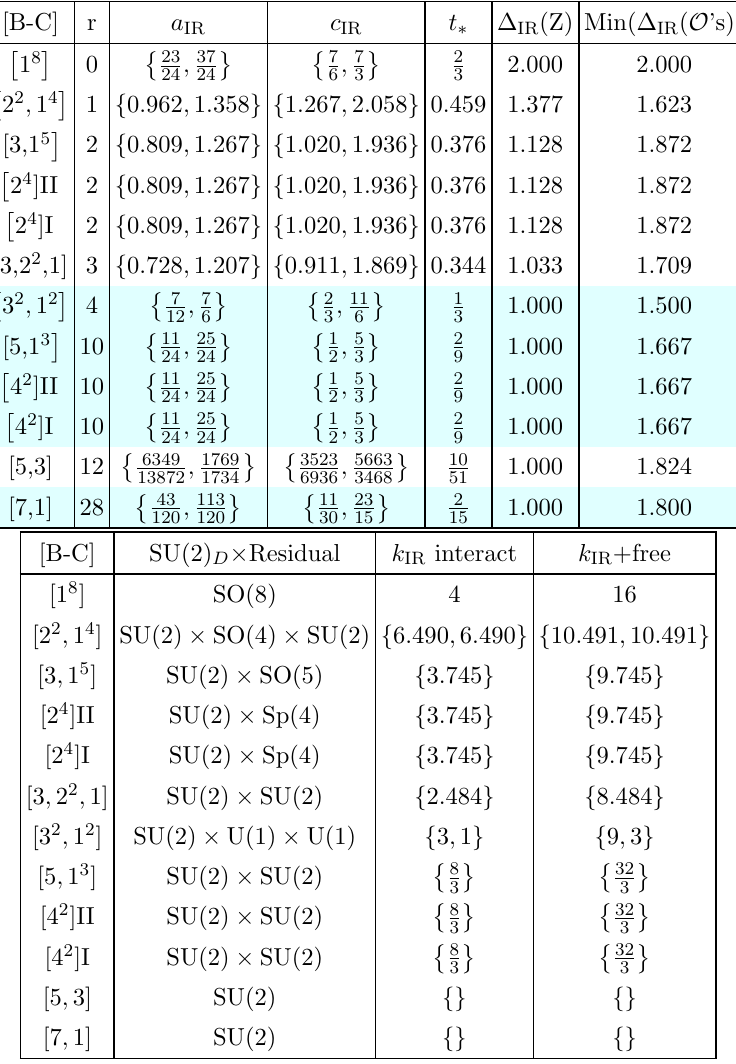
Table 10. Flipper (cid:12)eld deformations of the probe D3-brane theory with D 4 (cid:13)avor. The top table has the central charges a IR and c IR as well as scaling dimensions while the table below contains the information about the (cid:13)avor central charges. The cyan highlighted entries align with the H 0 , H 1 and H 2 Argyres-Douglas theories, as (cid:12)rst noted in [16, 17]. The other rational entry with partition [5,3] also aligns with